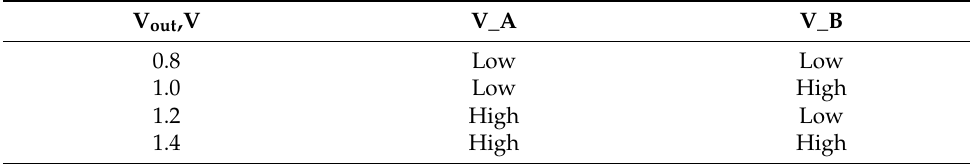
Figure 12. Output voltage of proposed MVD-LDO. The test configuration setup with digital logic is presented in Table 1. Table 1. Test configuration of MVD-LDO